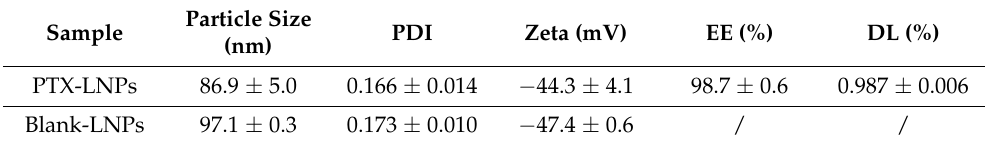
Table 2. The Physicochemical Characterization of PTX-LNPs and